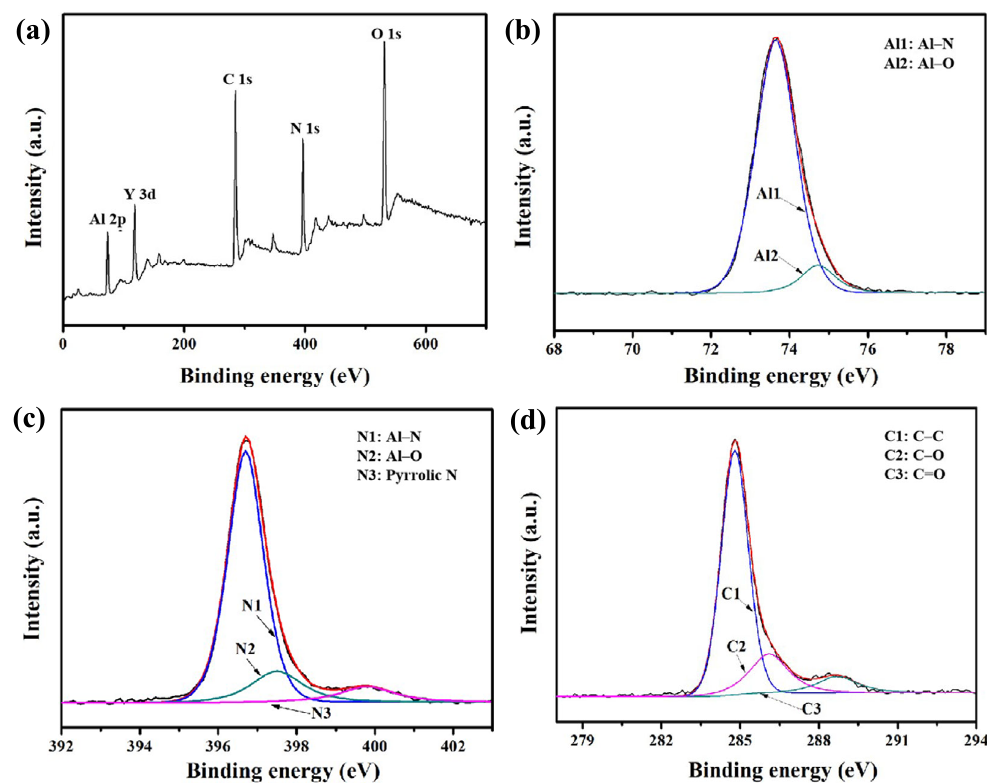
Fig. 4 (a) XPS survey spectra of 4 wt% composite and (b–d) the spectra of Al 2p, N 1s, and C 1s, respectively.